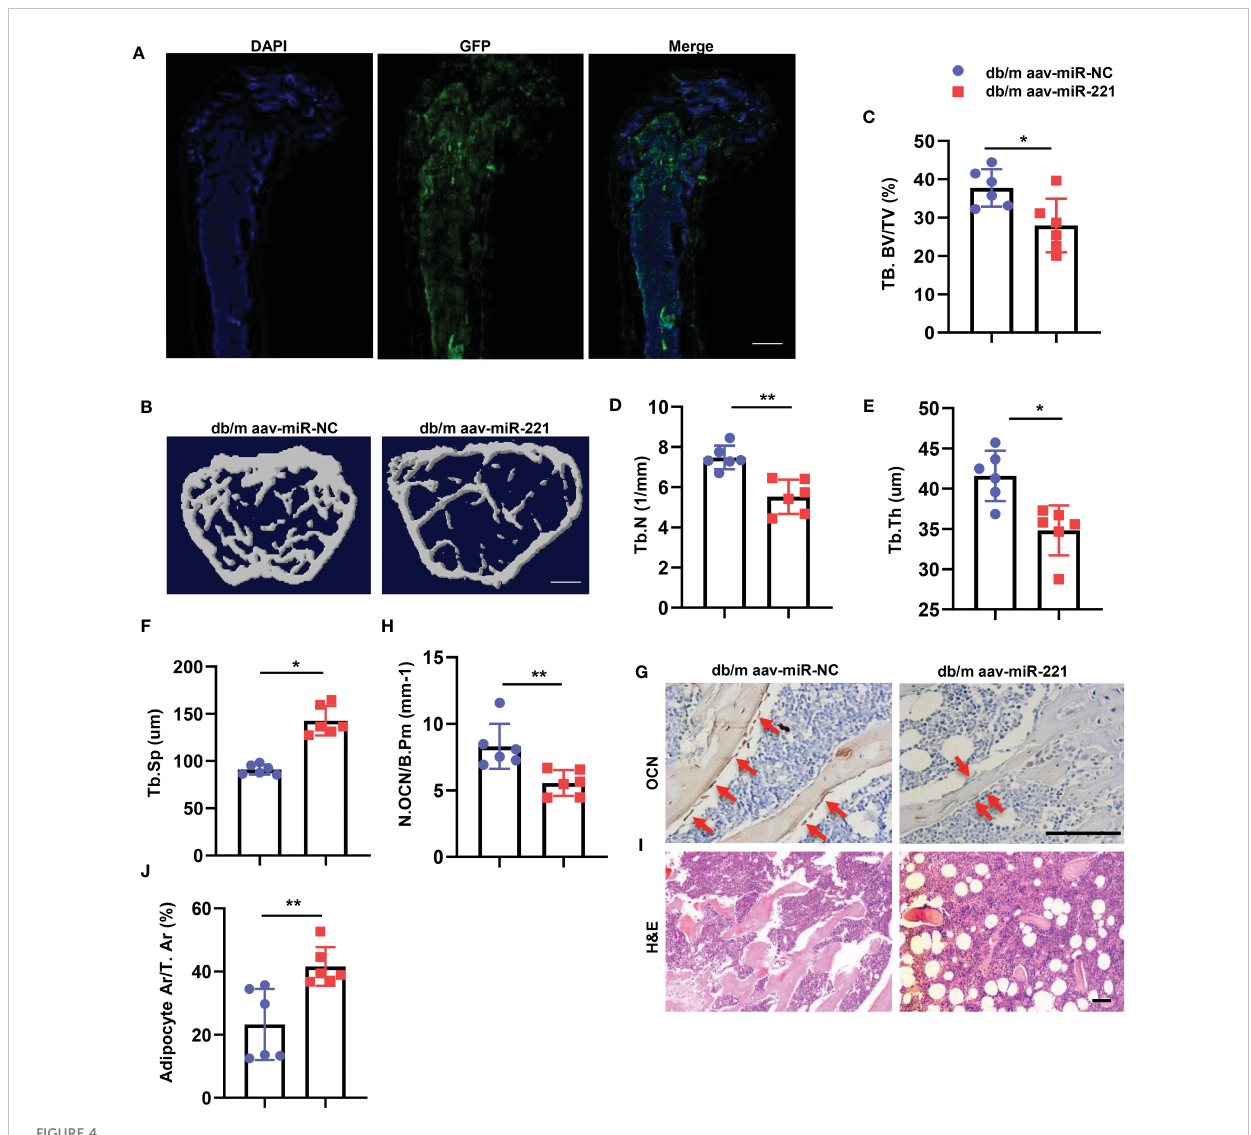
FIGURE 4 Overexpression of miR-221 in normal mice showed bone loss and marrow fat accumulation. (A-F) Intramedullary injection of 30ul 1.0E+12 vg/ml AAV-microRNA-NC-EGFP and AAV-microRNA-221-EGFP in normal mice, six weeks after AAV injection, the femur were collected for further analysis. Representative fl uorescent images of GFP expression, blue fl uorescence marks the DAPI-labeled nucleus and green fl uorescence indicates successful virus injection (A) . Scale bar: 5mm; Representative micro-computed tomography ( m CT) image (B) ; Quantitative m CT analysis of trabecular bone volume (C) , Trabecular bone number (D) , Trabecular thickness (E) and Trabecular separation (F) , NC, normal control, n=6 per group. Scale bar: 1mm. (G, H) Representative images of osteocalcin immunohistochemical staining (G) and number of osteoblasts in the distal femur (H) , red arrows represent osteocalcin-positive – staining cells. Scale bar: 100 m m. (I, J) Representative images of H&E staining and area of adipose cells in the distal femur, respectively. Scale bar: 100 m m. The data is shown as the mean ± SD. * P <0.05, ** P <0.01